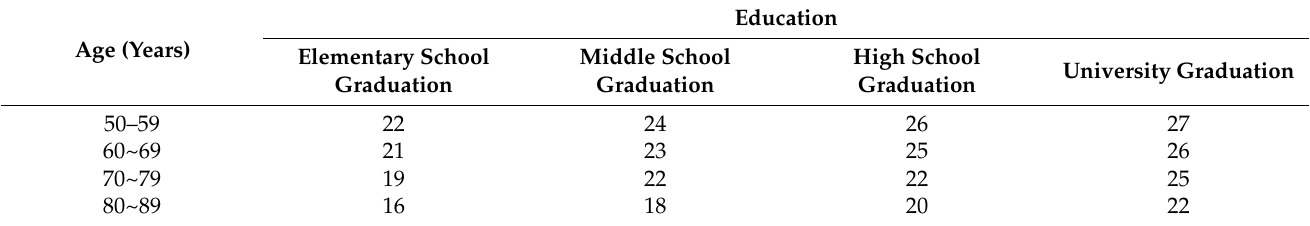
Table 1. Cognitive impairment screening test baseline